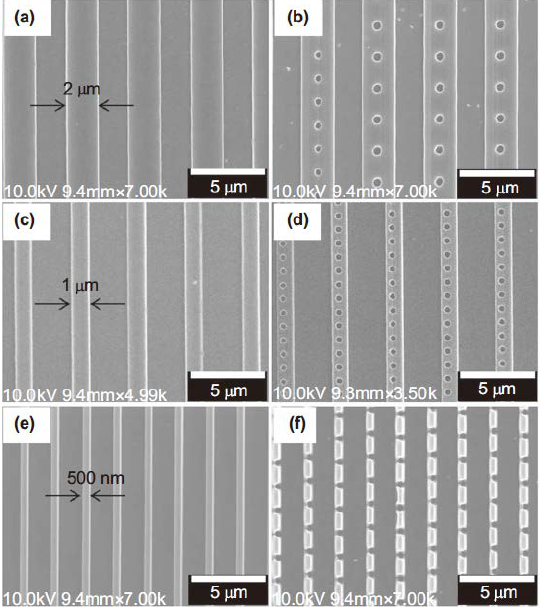
Figure 14: SEM images of polymer fibers fabricated by hybrid ad- ditive and subtractive fabrication processing using TPP followed by femtosecond laser multiphoton ablation. (a,c,e) Arrays of fibers formed using TPP with 2, 1, and 0.5 µ m in diameters, respectively. (b,d,f) Arrays of fibers with periodic hole patterns formed by fem- tosecond laser multiphoton ablation [127]. Reproduced with per- mission from Nature Publishing Group, © 2012 by Nature Publishing Group.